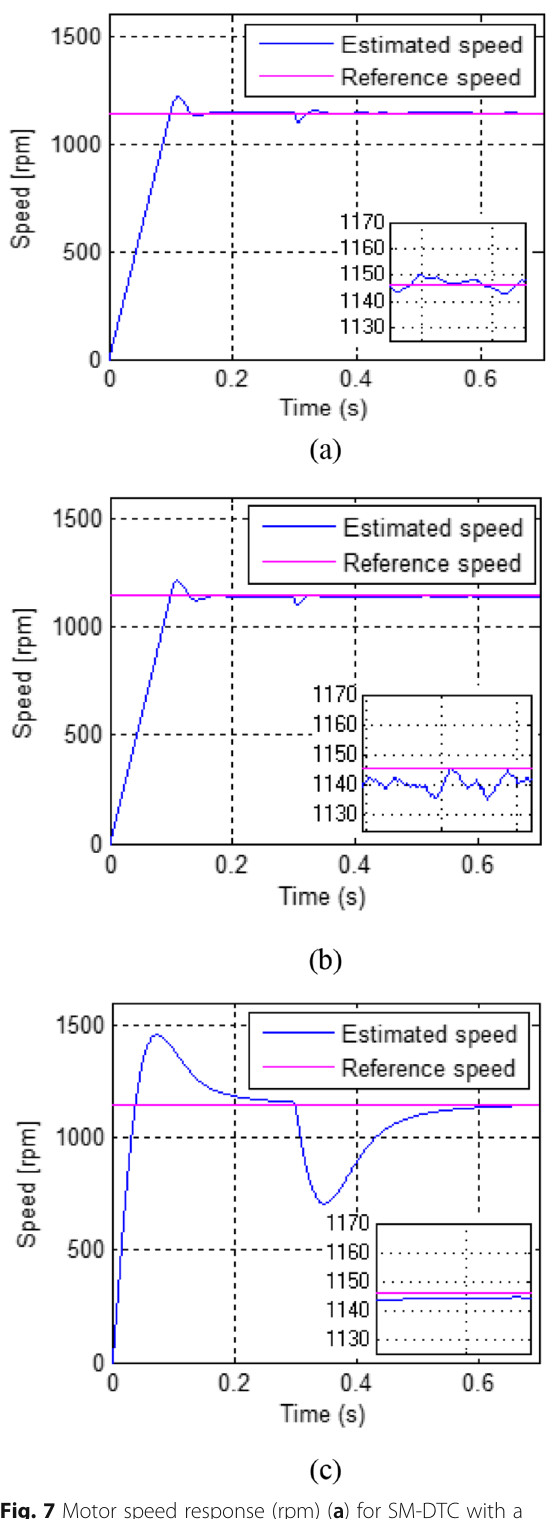
Fig. 7 Motor speed response (rpm) ( a ) for SM-DTC with a three-level NPC inverter, ( b ) for SM-DTC with a two-level inverter and ( c ) for PI-DTC with a three-level NPC